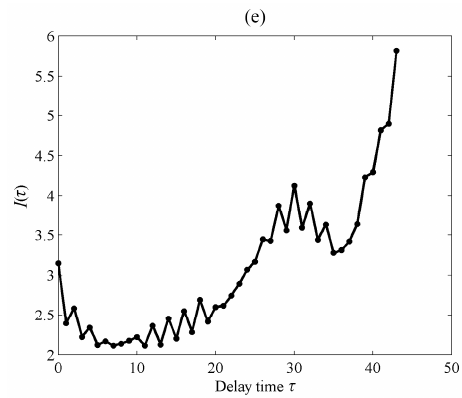
Figure 3. Delay time τ of several intrinsic mode functions (IMFs) for Shangjingyou station (( a ) IMF1; ( b ) IMF2; ( c ) IMF3; ( d ) IMF4; and ( e ) IMF5).